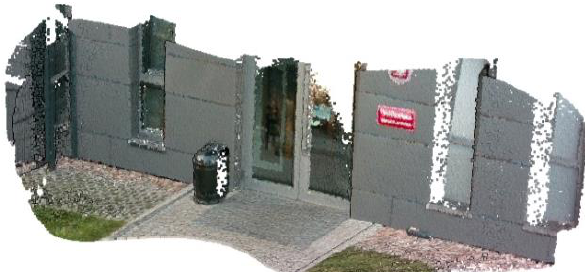
Figure 9: RGB camera-LiDAR relative pose calibration: detected lines in the RGB image from a RealSense camera (blue), in the point cloud (red) and correspondences between point sampled from them (green).